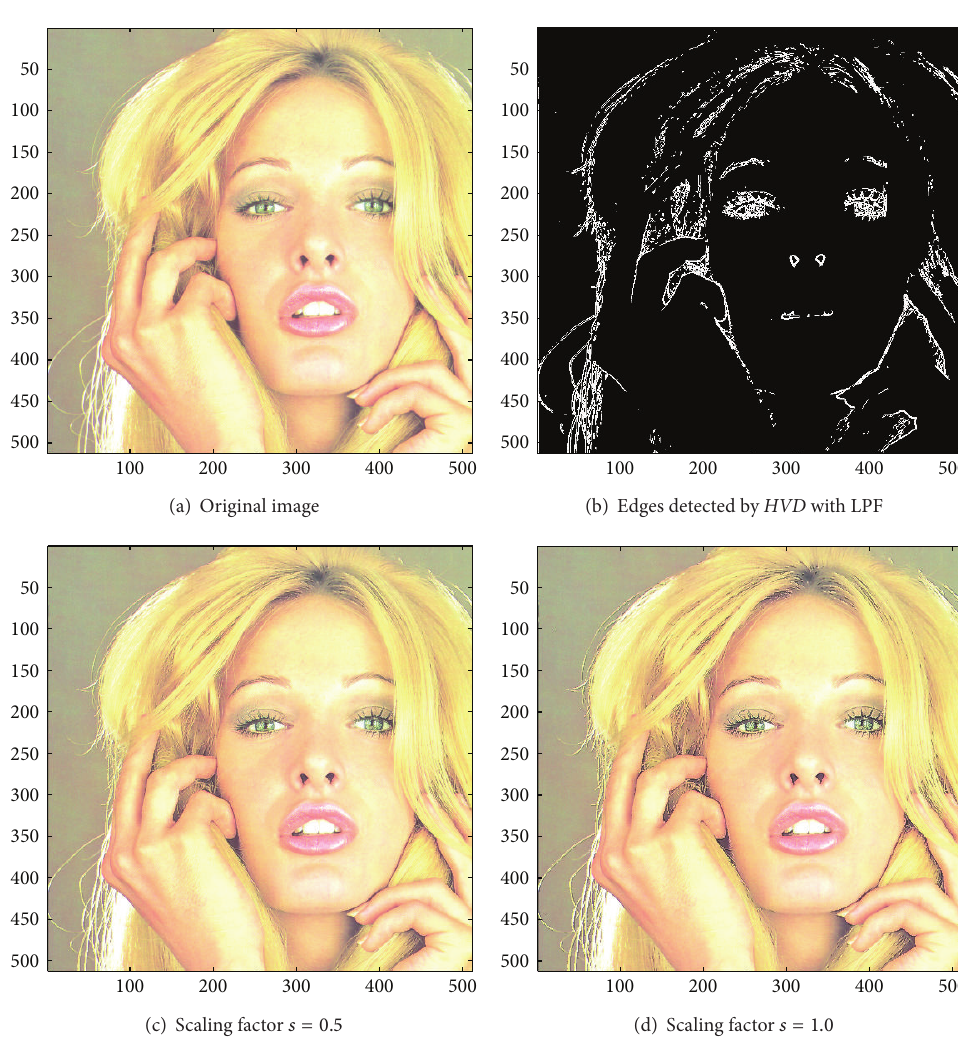
= 18 for HVD . (a) The image “Tiffany” (512 × 512 color image). (b) Edges detected by HVD with LPF. (c and d) Sharpened Figure 13: 𝜃 eth results by HVD with scaling factors 0.5 and 1.0 ,